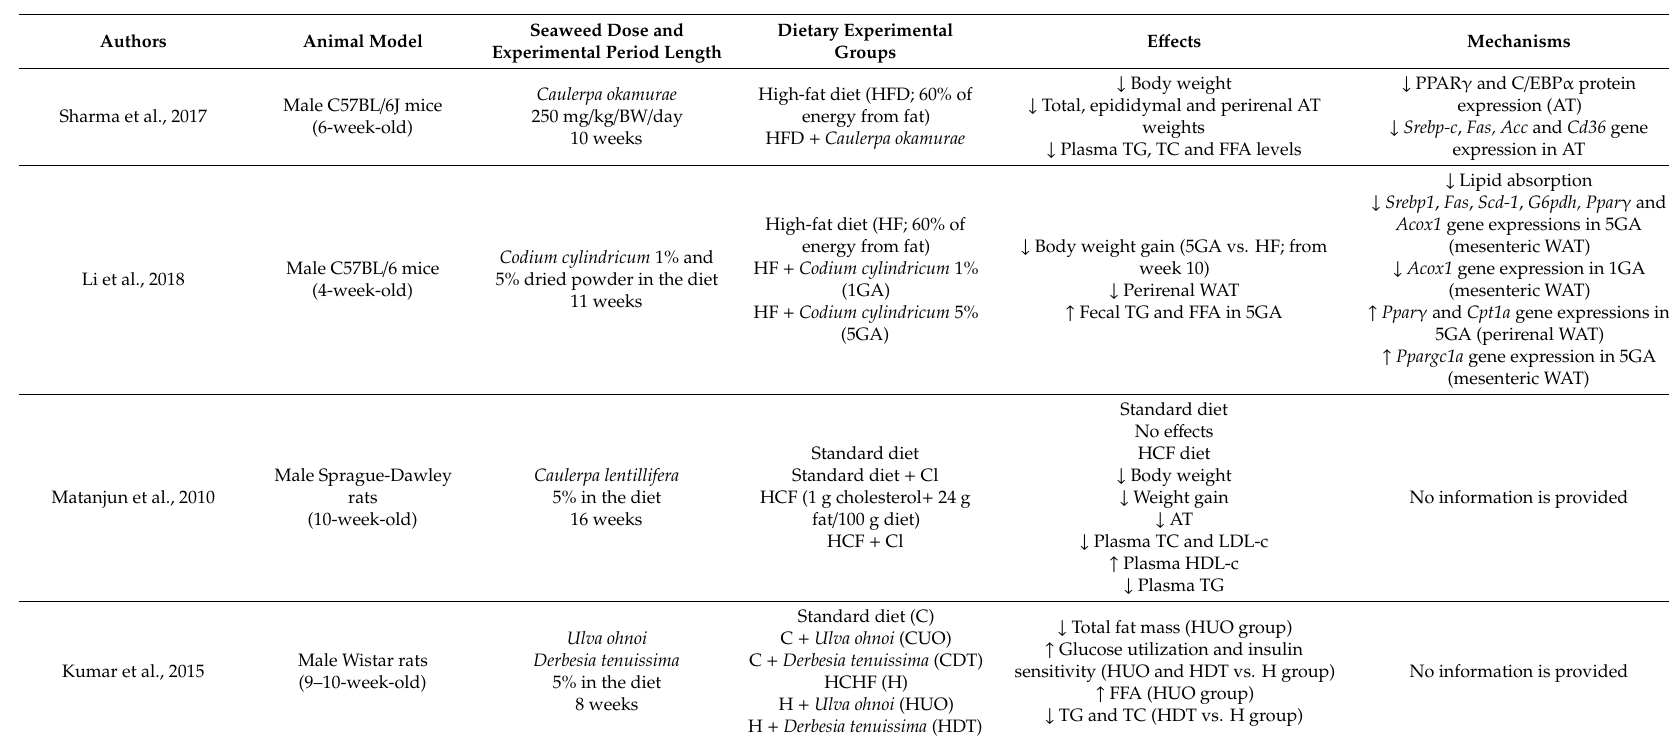
Table 4. In vivo e ff ects of green seaweeds in di ff erent animal